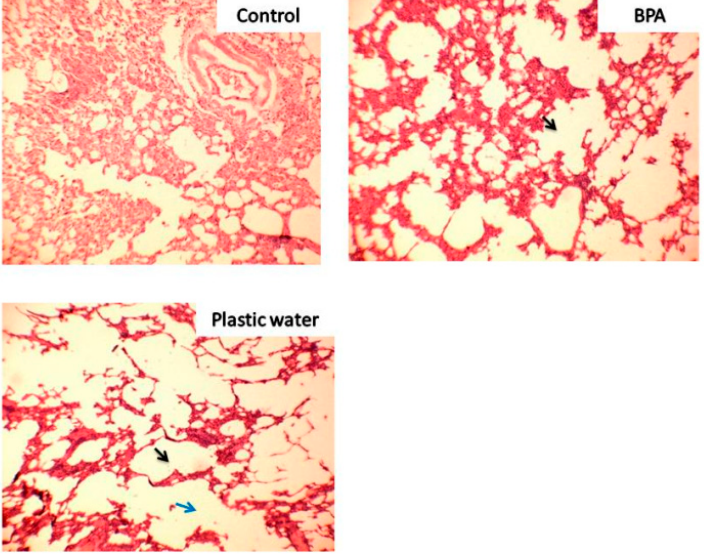
central veins in both the treated groups. Loss of normal cytoarchitecture is also seen in both the